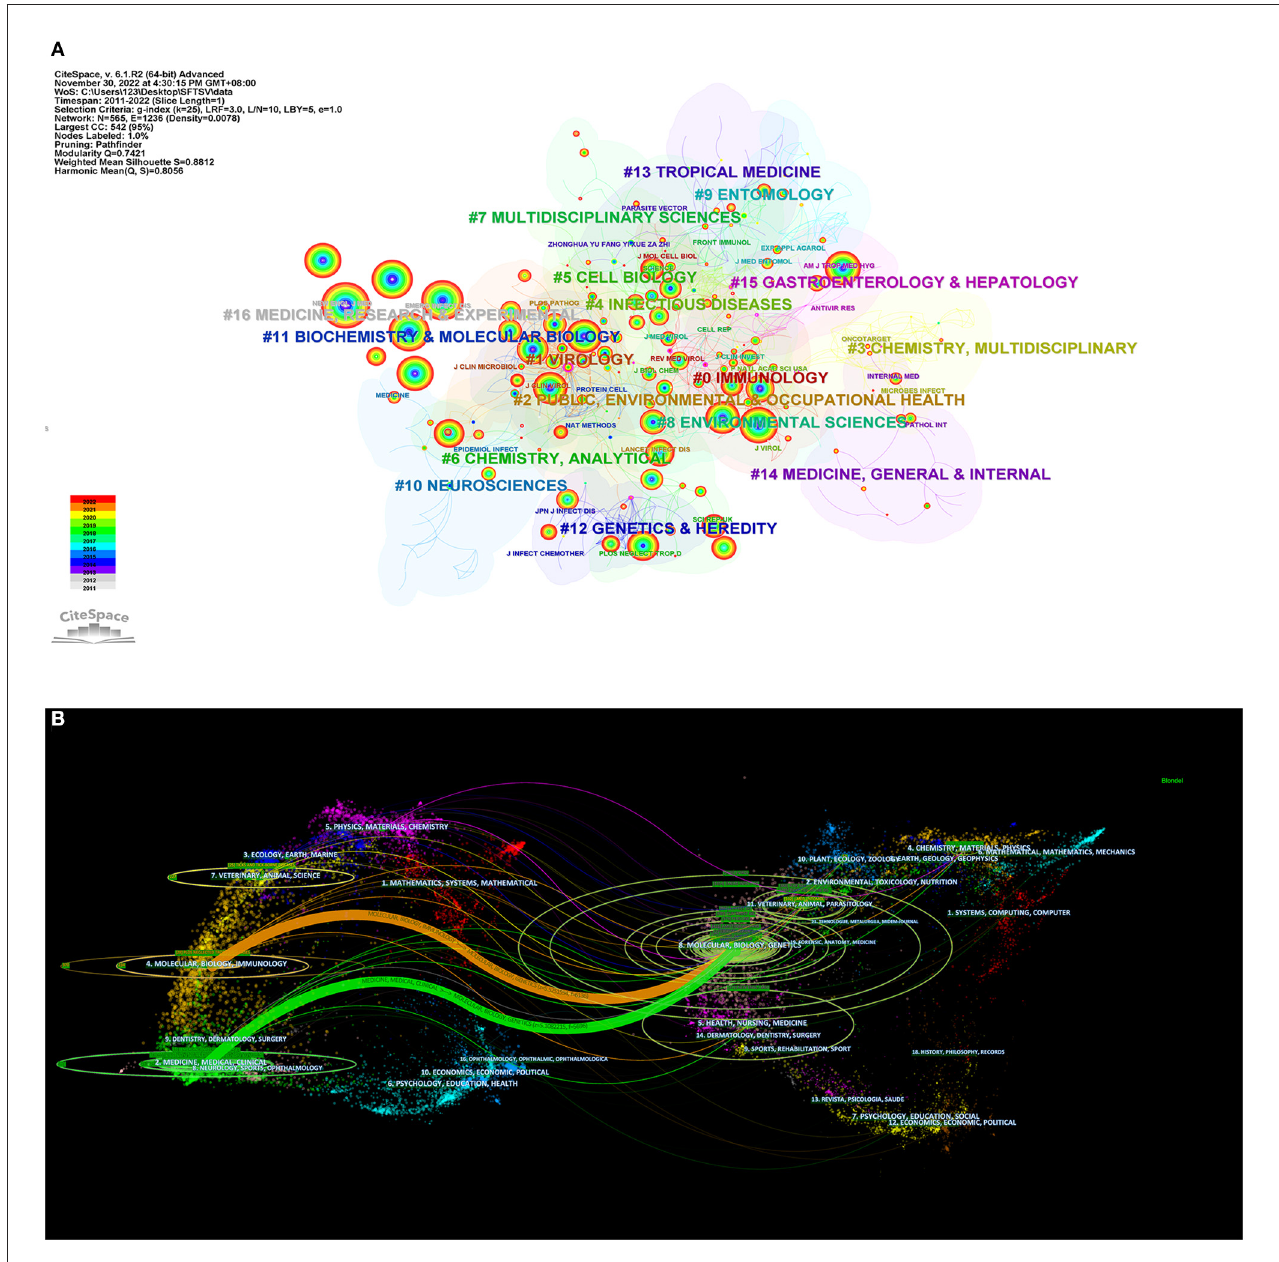
FIGURE3 Contributions of top journals on SFTSV. (A) Journal co-citation network of clustering subjects categories. (B) A dual-map overlap of journals on SFTSV research by citespace (distribution of cited literature and journals on the left and articles that cited literature on the